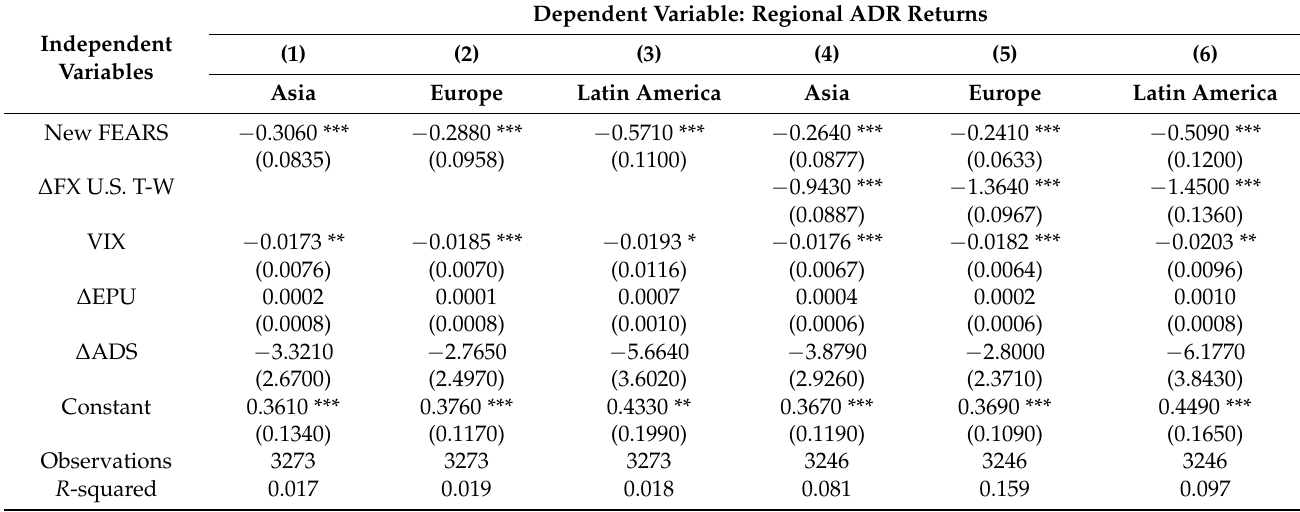
Table 5. New FEARS and ADR regional